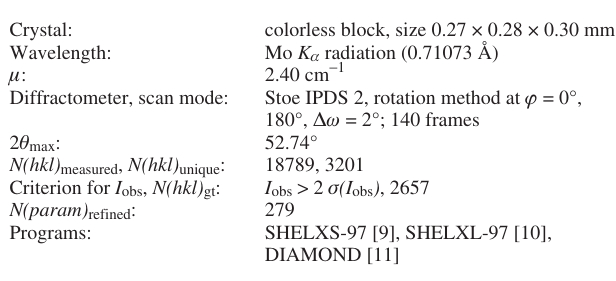
Table 1. Data collection and handling.